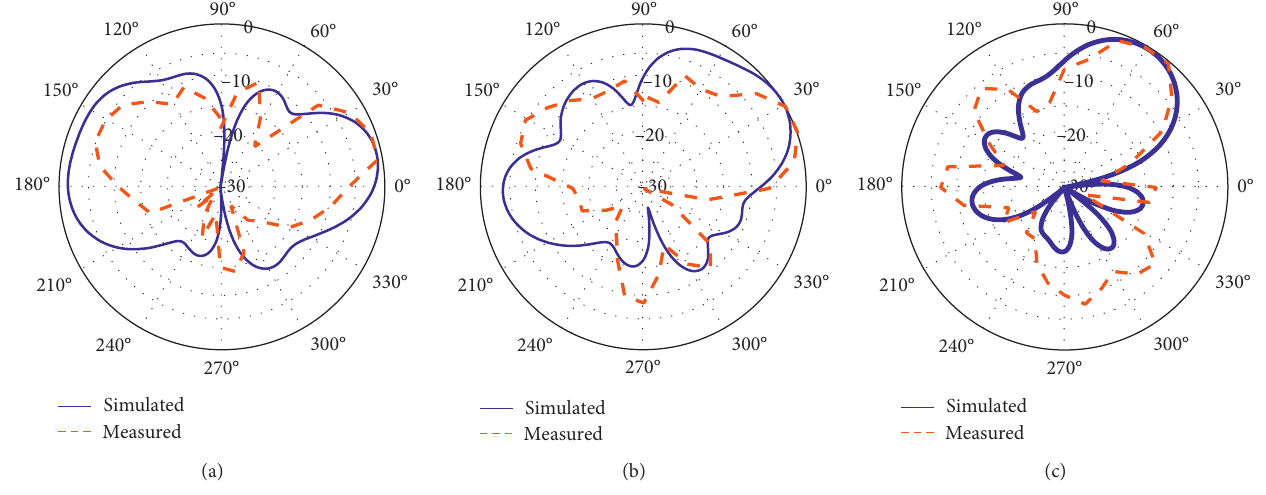
Figure 15: Measured results for (a) θ